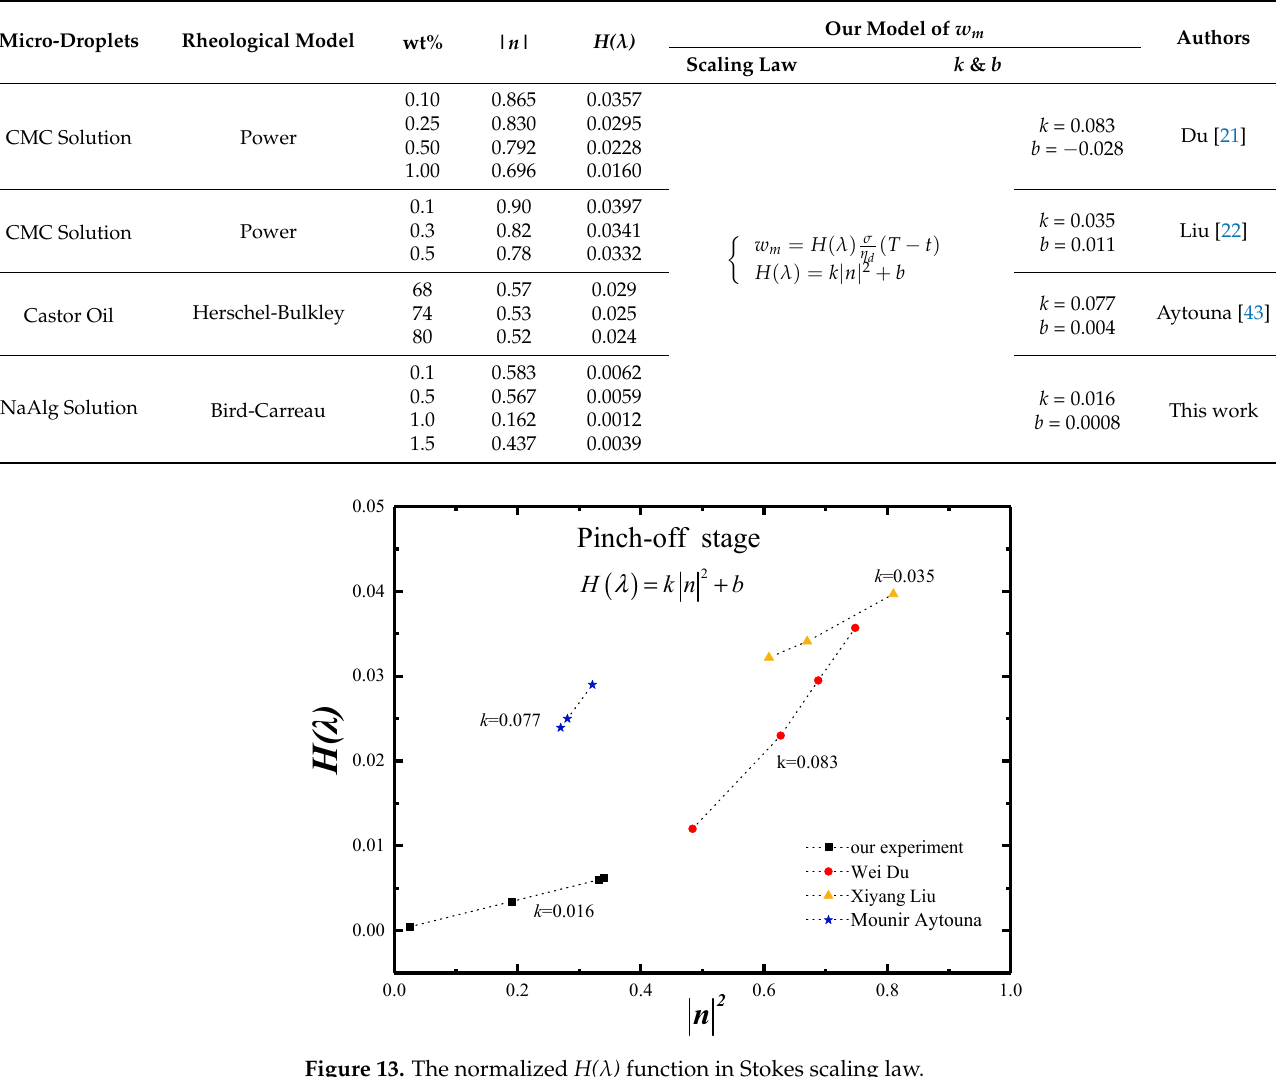
Figure 13. The normalized H( λ ) function in Stokes scaling law.